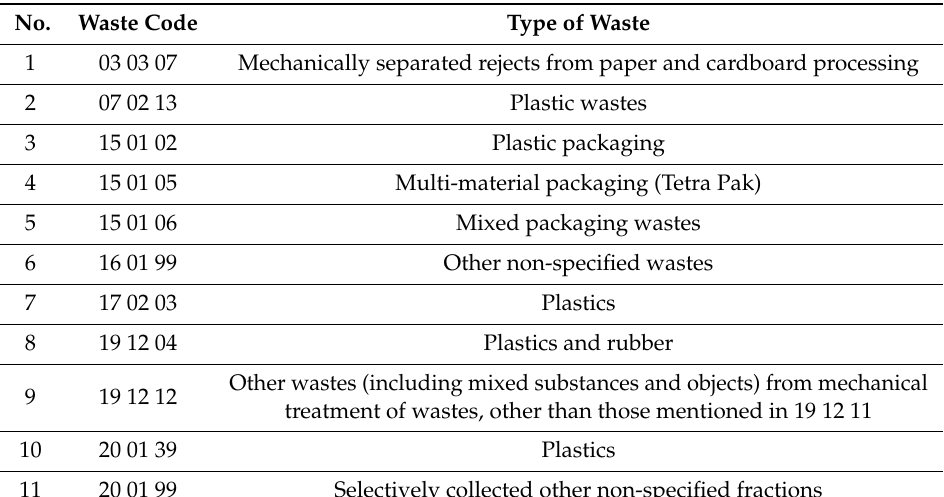
Table 1. Wastes processed by the GreenTech